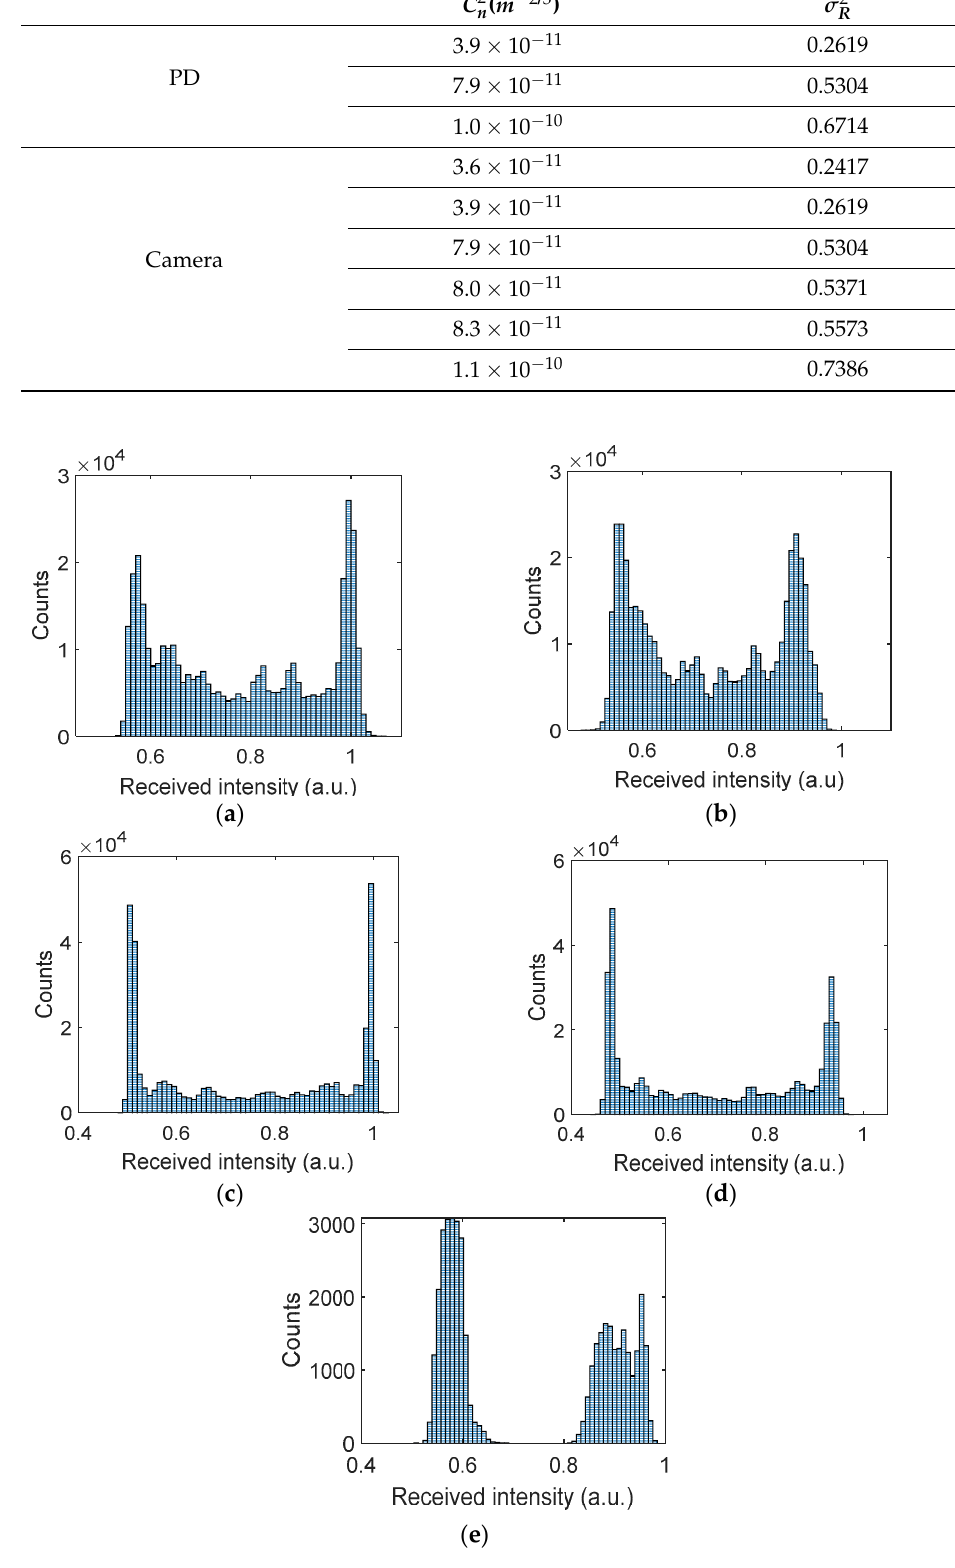
Figure 7. Camera Rx histogram plot: prior detection module for ( a ) gain 1.07 × with no AT, ( b ) gain 1.07 × with the highest AT scenario, 𝐶 (cid:3041)(cid:2870) = 1.0 × 10 (cid:2879)(cid:2869)(cid:2868) m (cid:2879)(cid:2870) (cid:2871)⁄ , ( c ) gain 3.96 × with no AT, and ( d ) 1.07 × with the highest AT scenario, C 2 n = 1.0 × 10 − 10 m − 2/3 , ( c ) gain 3.96 × with no AT, and ( d ) gain gain 3.96 × , with the highest AT scenario 𝐶 (cid:3041) (cid:2870) = 1.1 × 10 (cid:2879)(cid:2869)(cid:2868) m (cid:2879)(cid:2870) (cid:2871)⁄ ; and ( e ) output of the sampler for 3.96 × , with the highest AT scenario C 2 n = 1.1 × 10 − 10 m − 2/3 ; and ( e ) output of the sampler for ( a ( a ).